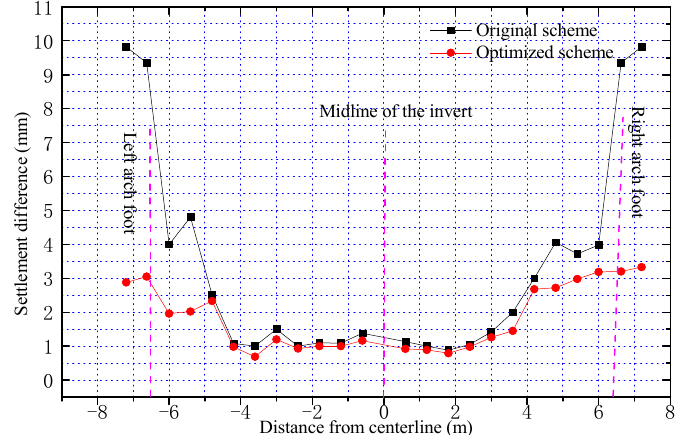
Figure 15. Plastic zone of optimization scheme.